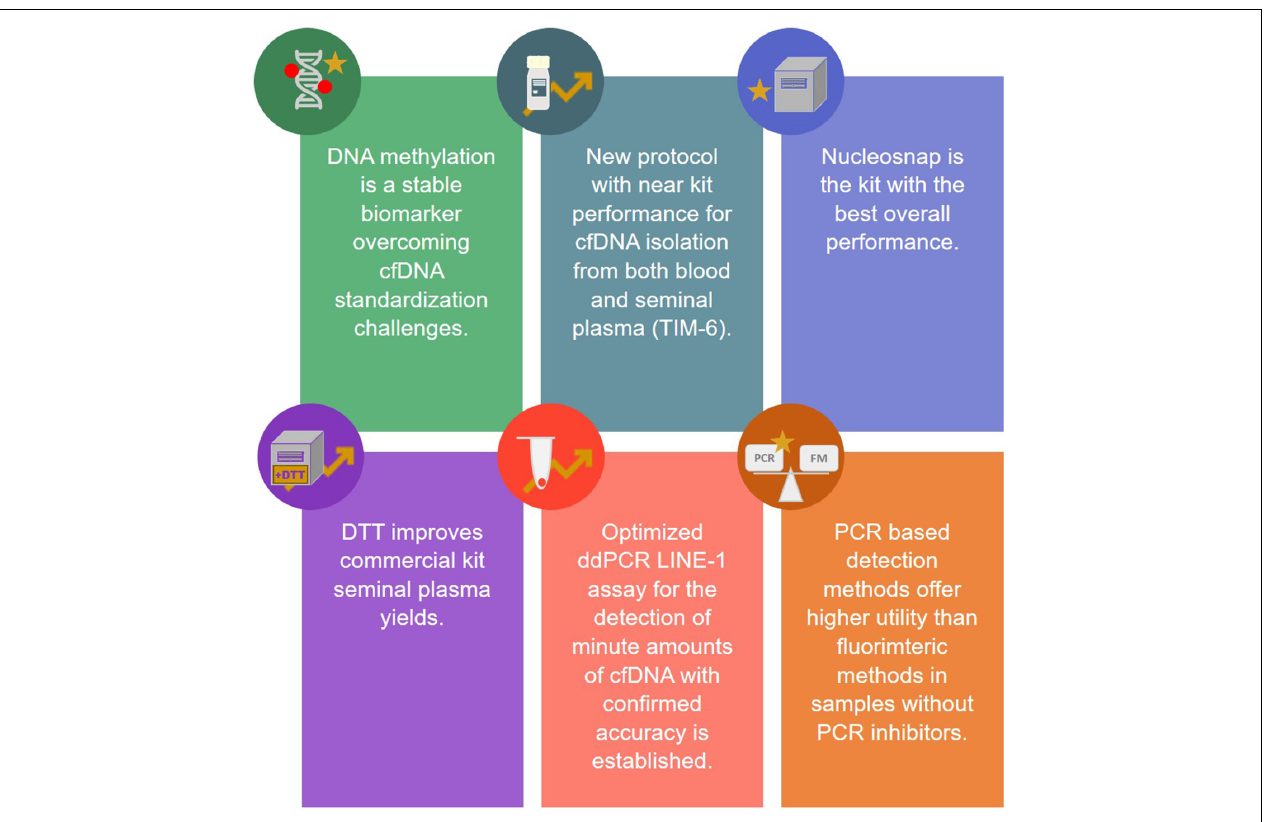
FIGURE 7 | Key points. Short depiction of the takeaway points of this